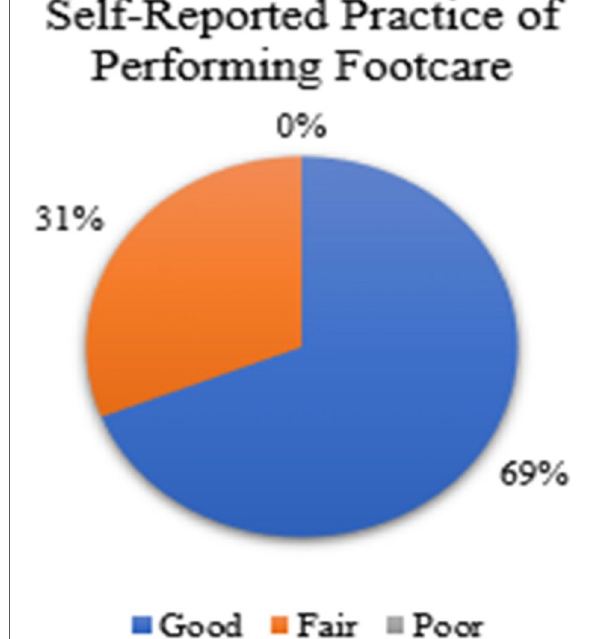
Fig. 5 Distribution of the self‑reported practice of performing footcare ( n =